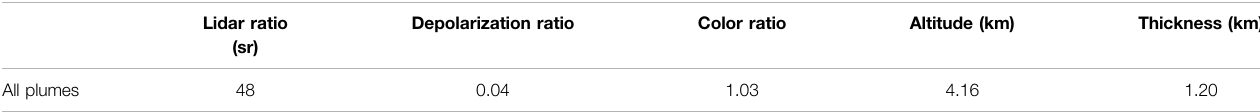
TABLE 3 | Summary of smoke plume characteristics from the Sheridan Fire fl own on 15 August 2019. Median vales of Sheridan Fire plume